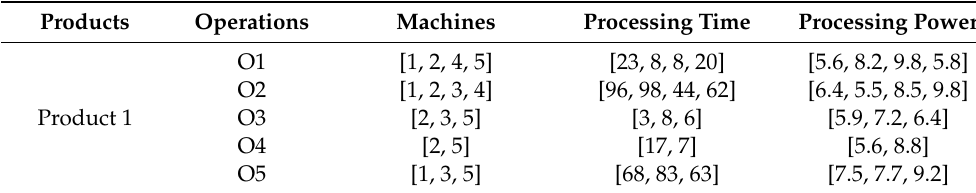
Table 5. The processing data for the products in case